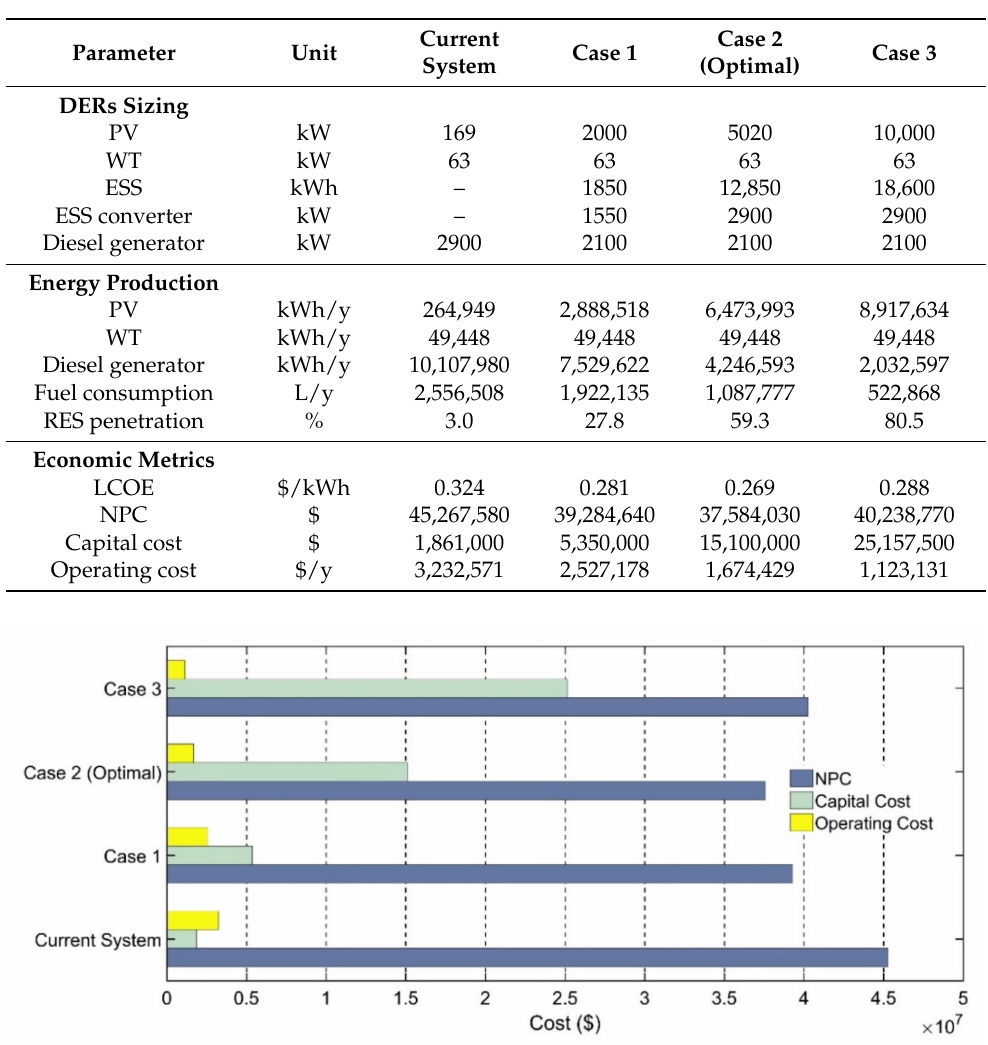
Table 5. Results of selected cases for Deokjeok Island microgrid.